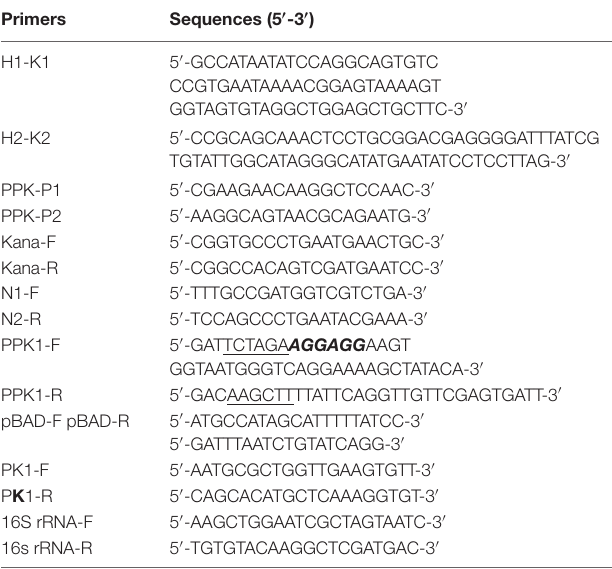
TABLE 1 | Primer sequences used in the construction of the isogenic in-frame deletion mutant of ppk1 and ppk1 -complemented strains.